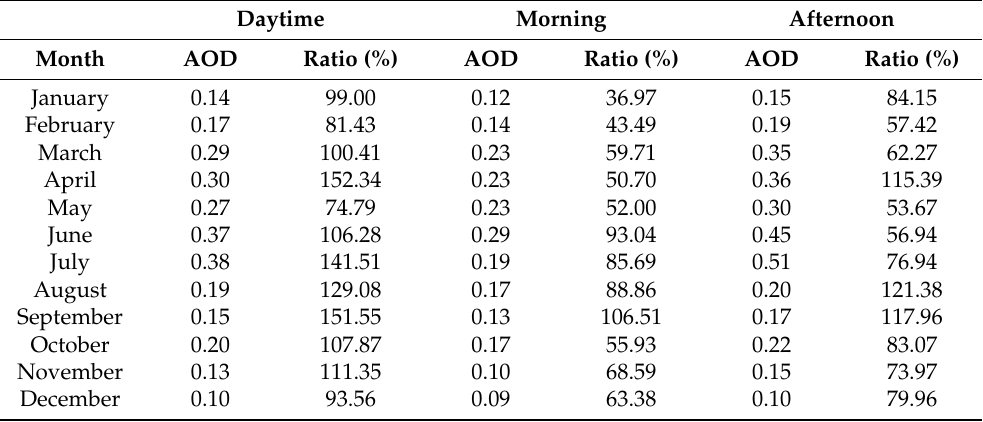
Table 1. Monthly mean statistics of the variation of the AOD at the MFYD Observatory. Daytime Morning Afternoon